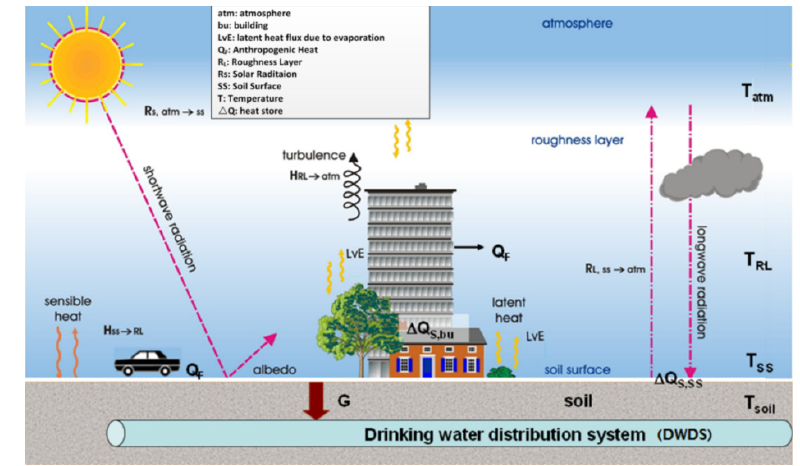
Figure 4. Measured temperature versus the calculated water mean age along flow routes for a network with two Service Reservoirs (SRs), with permission from the American Society of Civil Engineers (ASCE) [19].